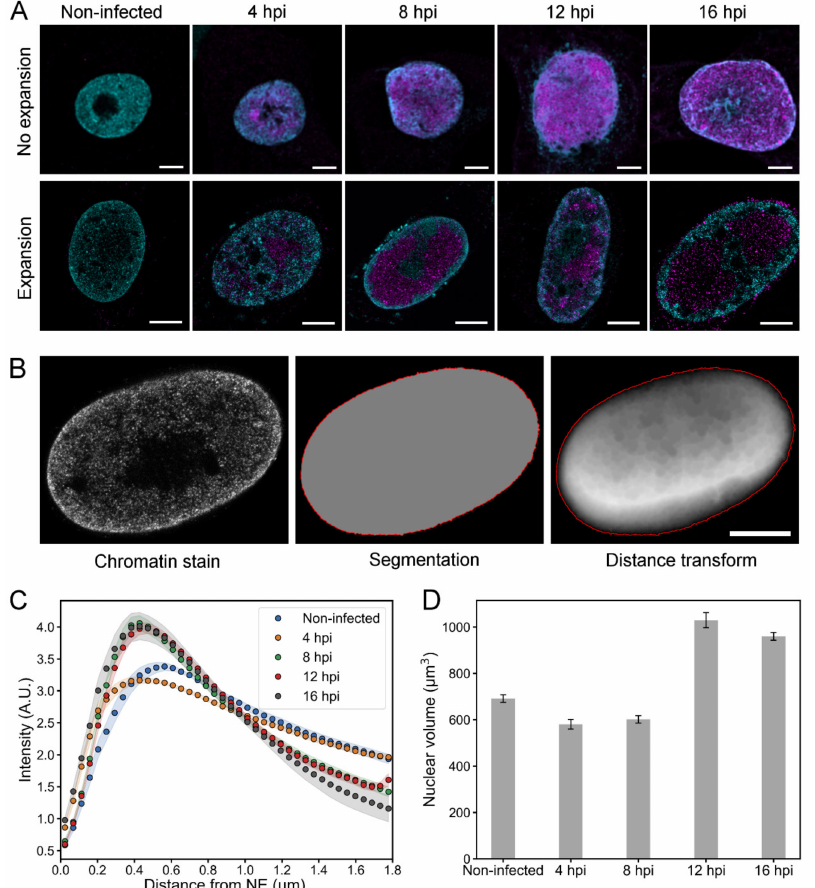
Figure 3. Chromatin distribution and nuclear volume of infected Vero cells. ( A ) Confocal microscopy slices of unexpanded and expanded nuclei of non-infected and infected cells at 4, 8, 12, and 16 hpi. Chromatin was stained with a mixture of histone Abs (H3K27ac, H3K9me3, H4K20me3; cyan) and viral capsid protein with VP5 MAb (magenta). Scale bars are 5 µ m. ( B ) A set of images showing a segmented nucleus and the positioning of its nuclear envelope (red) based on the chromatin